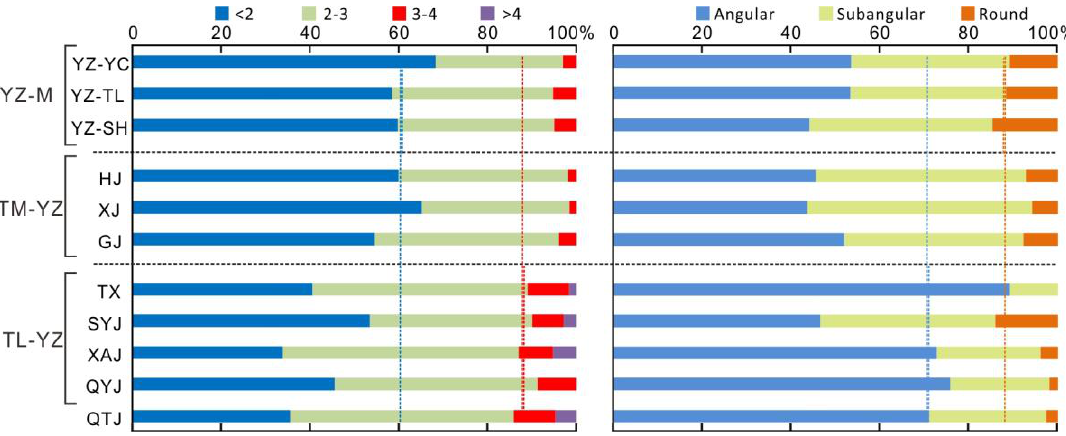
Figure 5. Zircon elongation and roundness of surface sediment samples in the Yangtze drainage and Qiantang River. YZ-M = Yangtze mainstream, TM-YZ = Tributaries of the Middle Yangtze, TL-YZ = Tributaries of the Lower Yangtze. Please see Figure 1 for the explanation of the abbreviations of some place names.